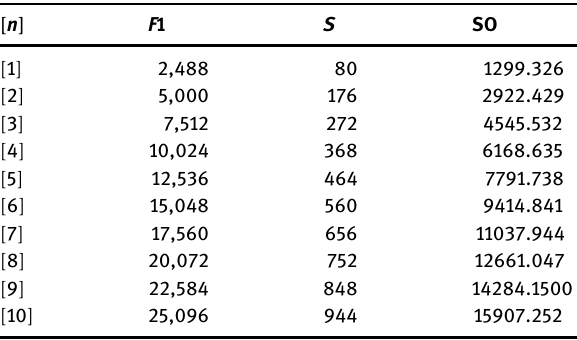
Table 4: Computation of topological invariants by the help of F - polynomial, S - polynomial, and SO - polynomial of TM -